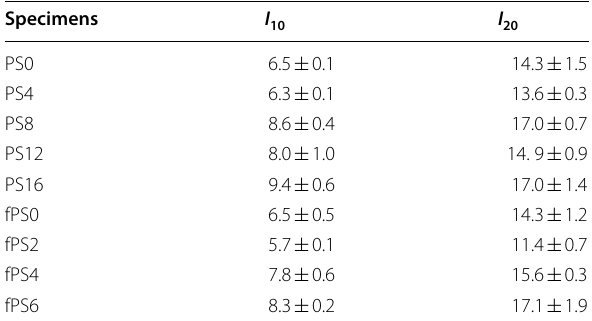
Table 5 Hybrid effects of PP fibres and MSF on ductile index and toughness index of fibre-reinforced MPC